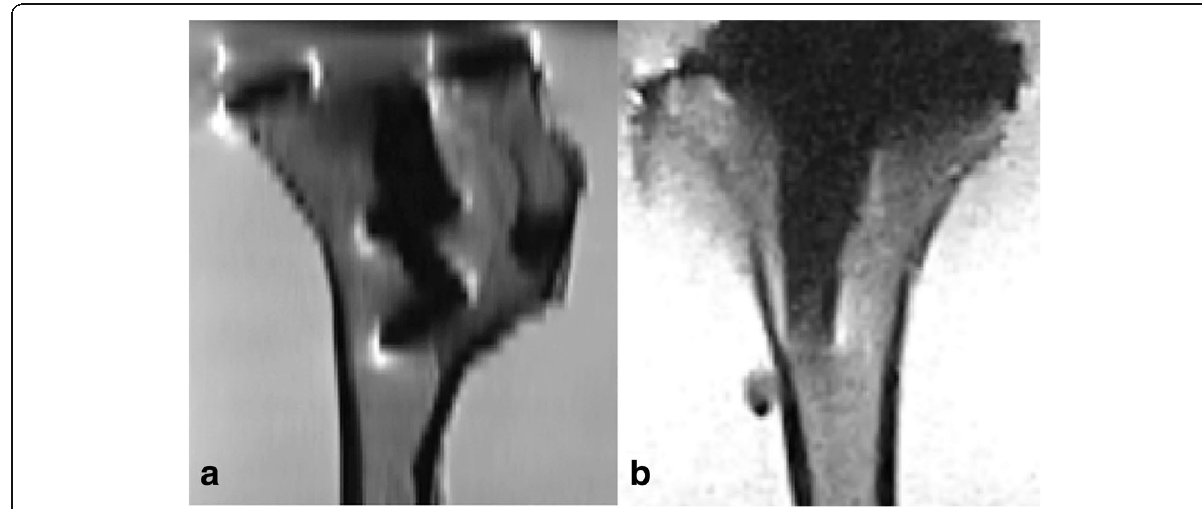
Fig. 1 a MRI slices of the tibial component of a total knee prosthesis made with high field MRI with a TSE PD sequence in the sagittal direction. b MRI slices of the tibial component of a total knee prosthesis made with low-field MRI made with a TSE/FSE PD sequence in the sagittal